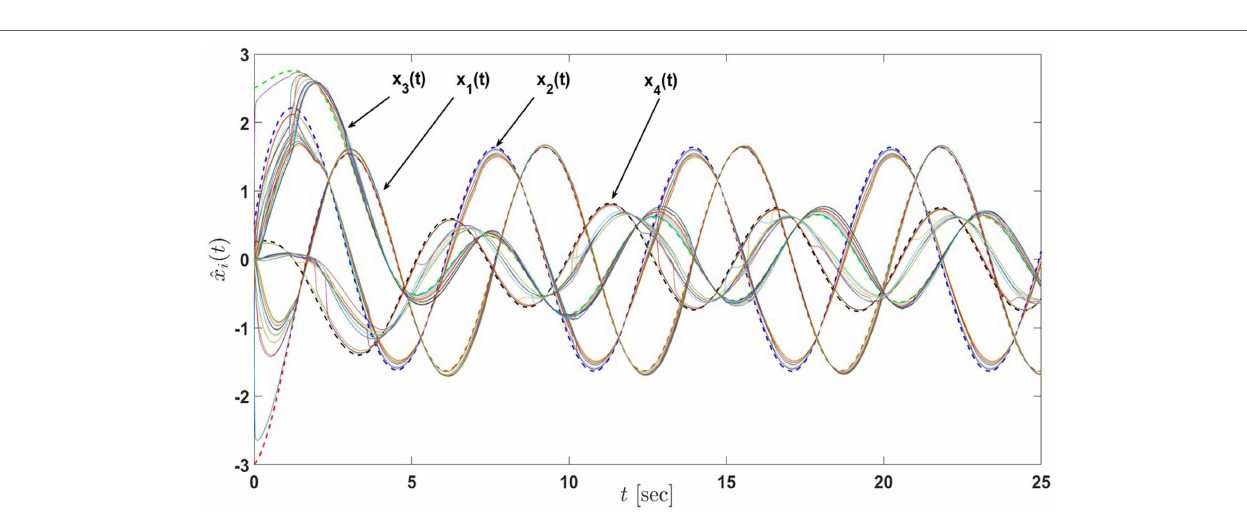
FIGURE 16 | State estimates of the active-passive sensor network in Example 4 with 12 nodes under the proposed architecture equations (58) and (59) with the decrease in (cid:27) i , i = 1, :::; 12 (the dash lines denote the states of the actual process and the solid lines denote the state estimates of nodes).